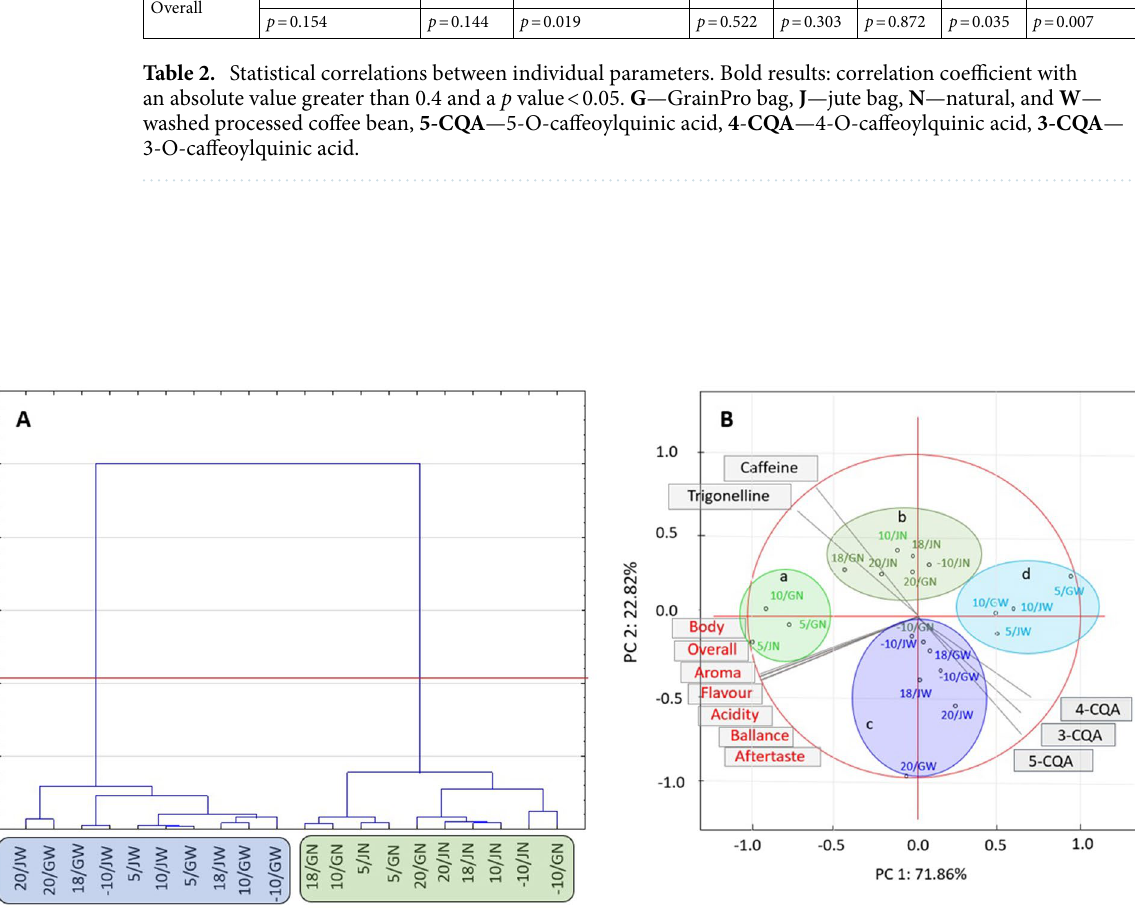
Figure 4. Chemical and sensory discriminants for the roasted coffees stored for 12 months. ( A ) Tree diagram. ( B ) Biplot of the projection of variables into the factor plane (Statistica, ver. 10, StatSoft). GW-GrainPro washed, GN-GrainPro natural, JW-jute washed, JN-jute natural, RC-roasted